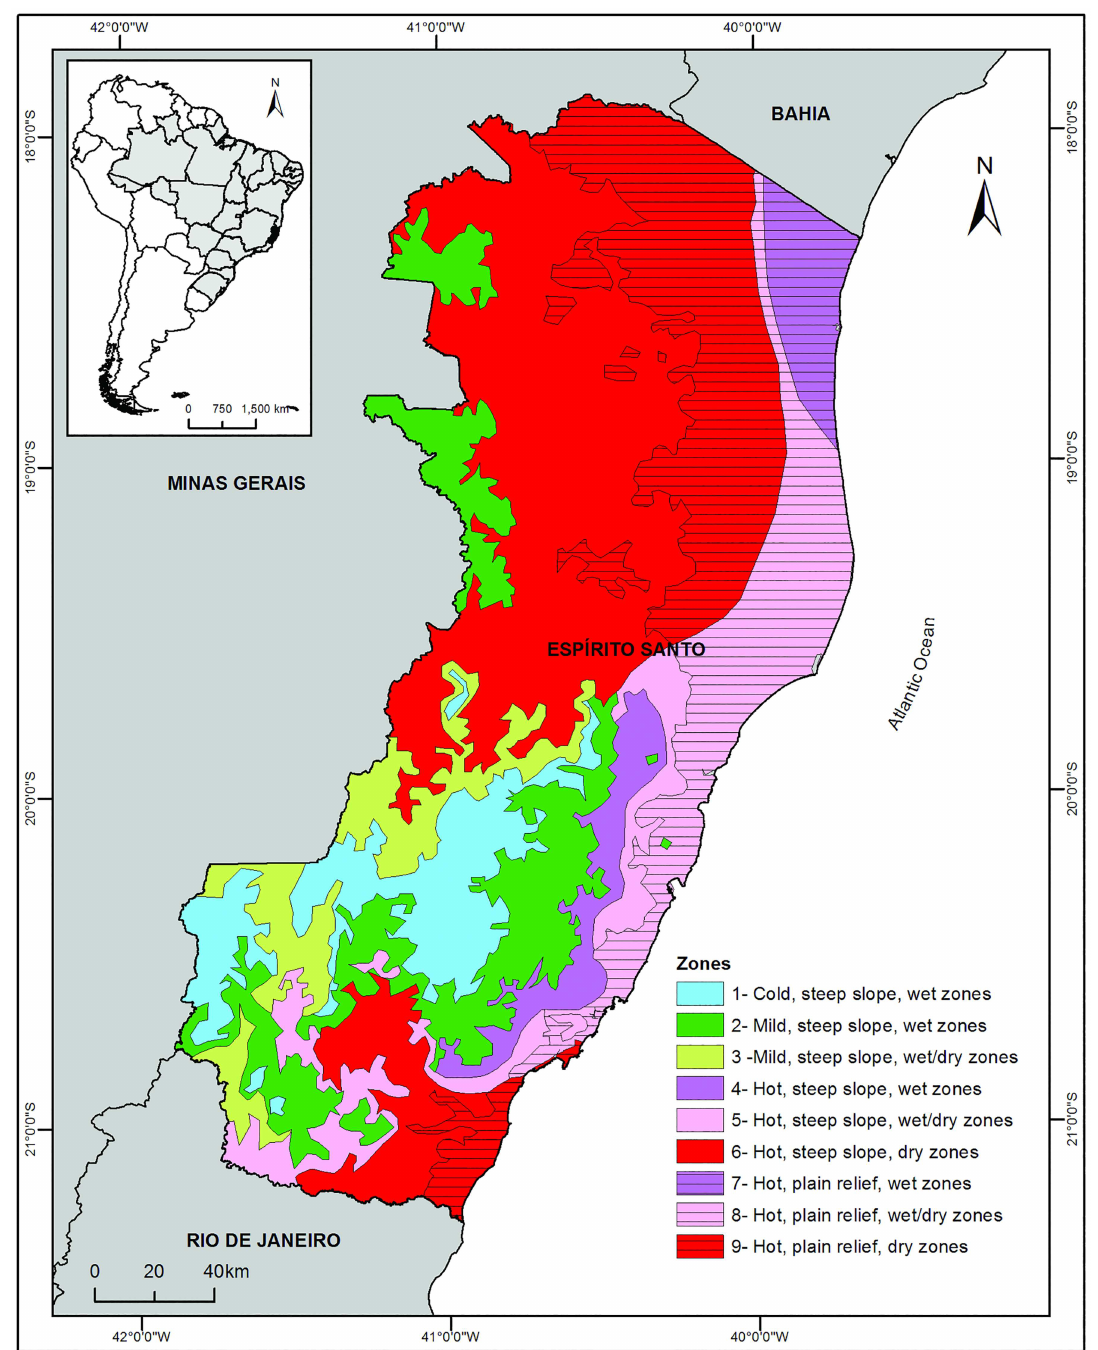
Fig 1. Geographical location of the state of Espı´rito Santo, southeastern Brazil, South America and the geo-climatic zones. By definition, a hot zone has a minimum average temperatureof 11.8–18.0˚C and a maximum of 30.7–34.0˚C. A mild zone has a minimum average temperature of 9.4–11.8˚Cand a maximum of 27.8–30.7˚C. A cold zone has a minimum average temperature of 7.3–9.4˚Cand a maximum of 25.3–27.8˚C. A steep slope zone has a slope above 8%, and a plain relief occurs when the slope is below 8%. A wet zone has < 4 dry months per year, a wet/dry zone has 4–6 dry months, and a dry zone has > 6 dry months [21]. Datum: SIRGAS